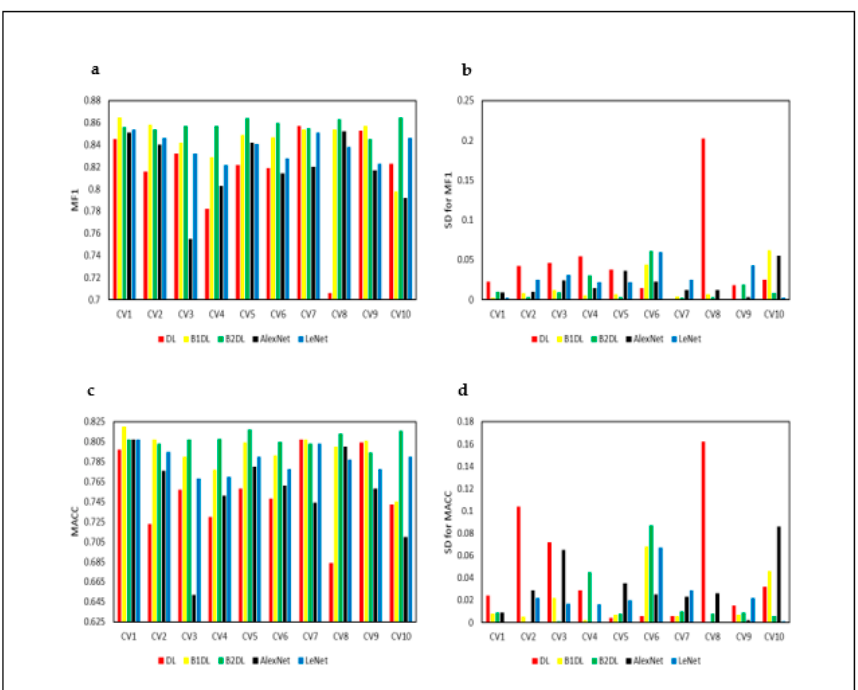
Figure 8. Performance results of the studied prediction algorithms, applied to test examples per- taining to in vitro bovine embryos. These results are obtained by running CV 10 times. CVi is the ith cross-validation. MF1 is the mean F1. MACC is the mean accuracy. SD is the standard deviation.